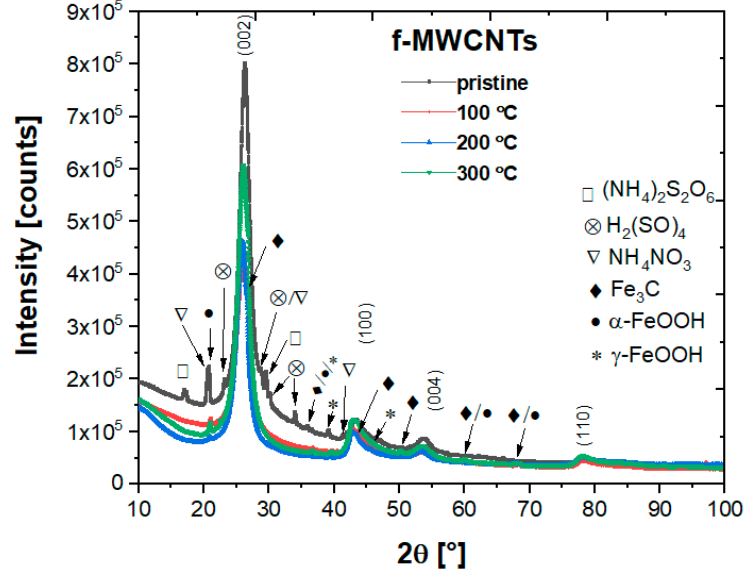
Figure 1. XRD diffractograms for pristine and calcined f-MWCNTs.